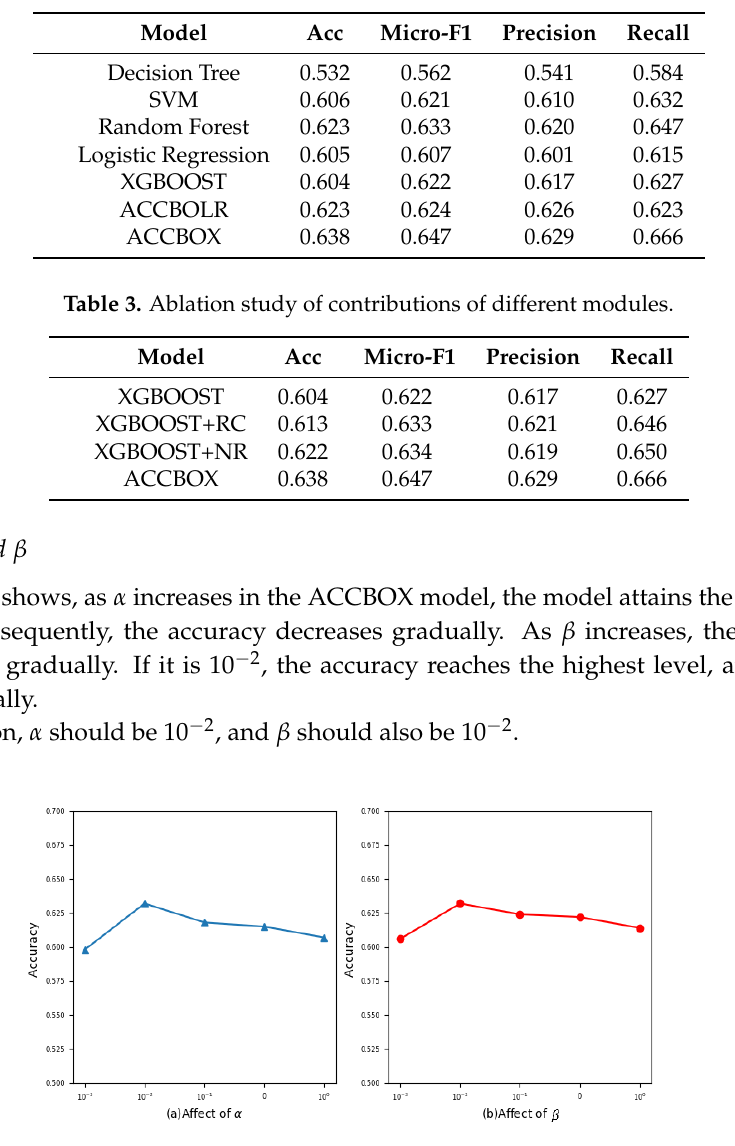
Figure 3. ( a ) Effect of reducing the model capacity. ( b ) Effect of a novel regularization